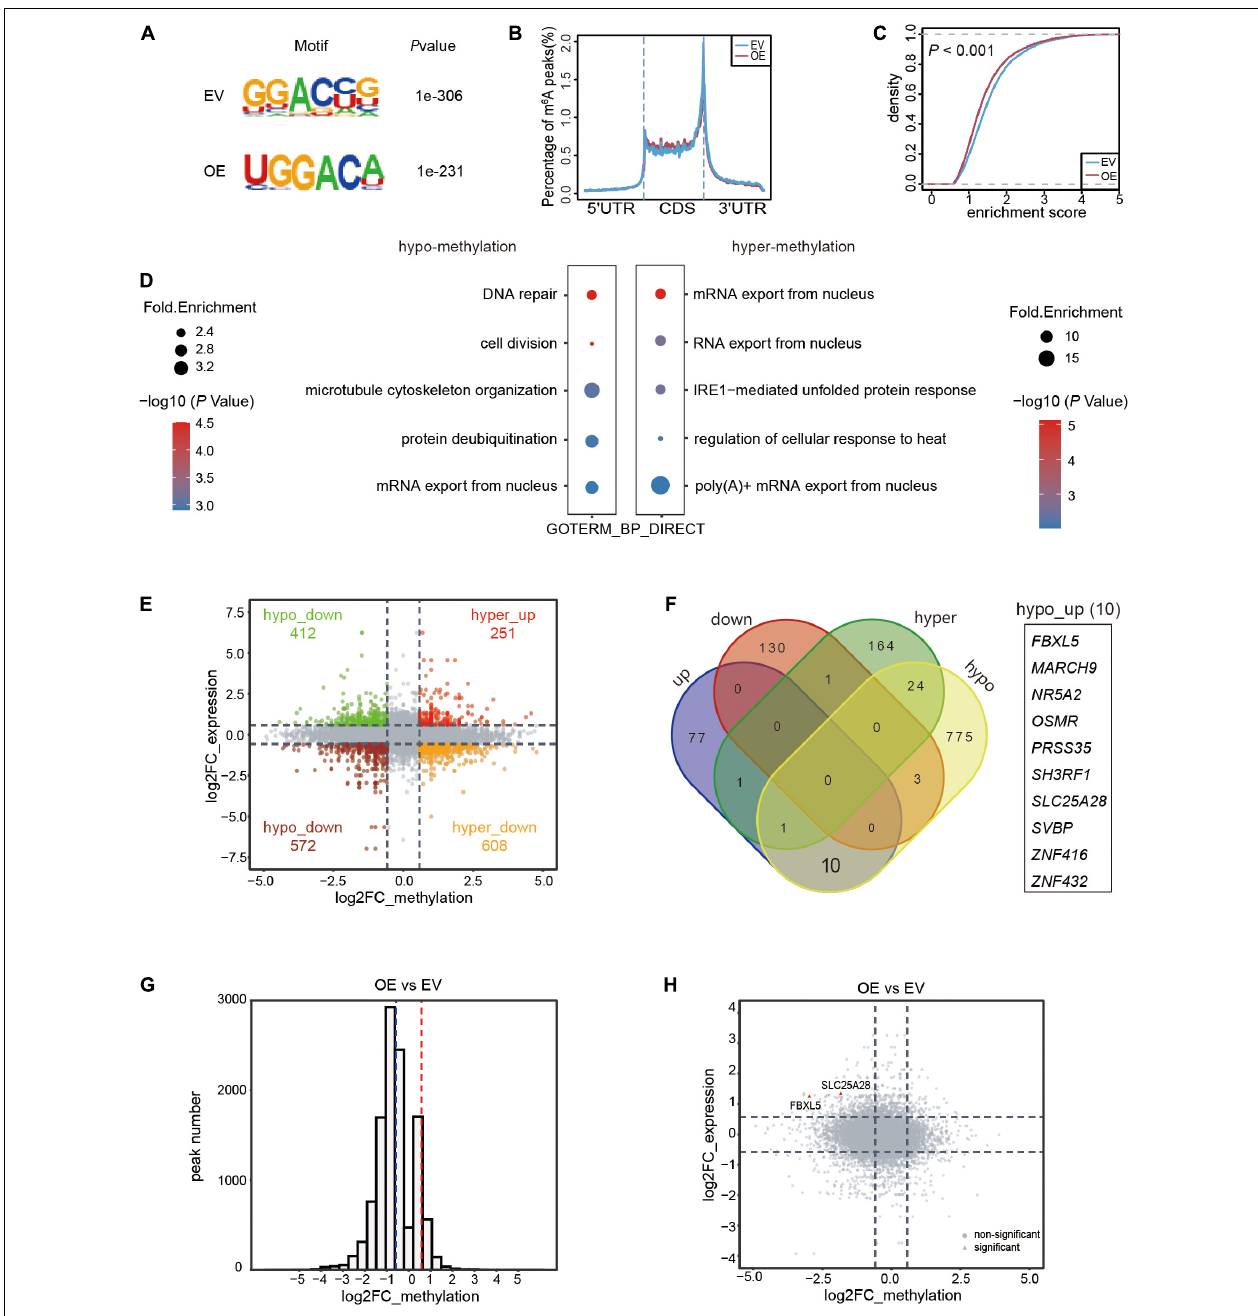
FIGURE 3 | Transcriptome-wide RNA m 6 A methylation and expression analysis of MIA PaCa-2 stable cell line with ALKBH5 overexpression. (A) Top consensus motif of m 6 A peaks identified in empty vector (EV) or ALKBH5-overexpressing (OE) MIA PaCa-2 cells. (B) Normalized distribution of m 6 A peaks across 5 (cid:48) UTR, CDS, and 3 (cid:48) UTR of mRNAs. (C) Cumulative distribution function of log2 enrichment score of m 6 A modified sites. (D) GO term analysis of transcripts with hypo- (left panel) and hyper-methylated (right panel) m 6 A sites in OE sample versus EV sample. (E) Scatter plot representing the log 2 FC of methylation ( x -axis) and expression ( y -axis) of each m 6 A peak in OE versus EV sample. Points with |log 2 FC| > 0.58 in both differential expression and methylation analysis results are highlighted. (F) Venn diagram showing the RNAs with significant change in either methylation (|log 2 FC| > 0.58 and FDR < 0.05) or expression (|log 2 FC| > 0.58 and P < 0.05) in OE sample. (G) Histogram showing the fold changes in m 6 A enrichment between OE and EV samples from total RNA based m 6 A data. Dotted lines denote the threshold (|log 2 FC| > 0.58) for filtering differential expression gene. (H) Scatter plot showing the distribution of fold changes in methylation ( x -axis) and expression ( y -axis) of each RNA in OE versus EV sample. Two RNAs with significantly decreased m 6 A methylation and increased expression level in OE sample are marked in red. Points in rectangle shape represent significant changes in methylation (|log 2 FC| > 0.58 and FDR < 0.05) and expression (|log 2 FC| > 0.58, P < 0.05), while the rest ones are shaped in circle.